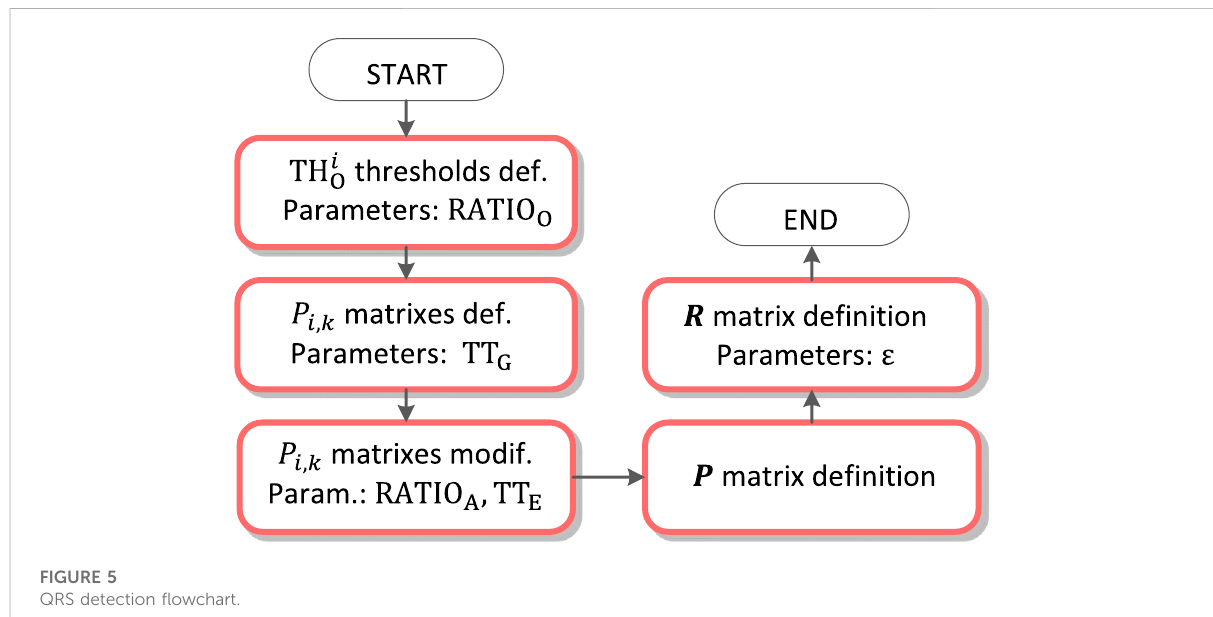
FIGURE 5 QRS detection fl